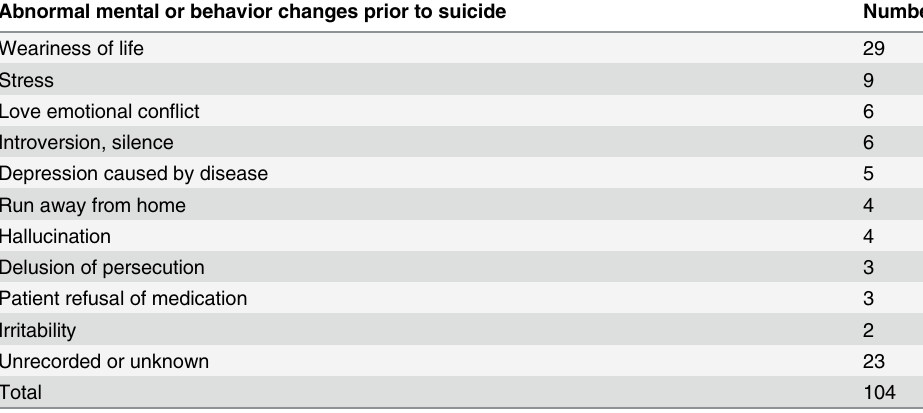
Table 6. Abnormal mental or behavior changes prior to